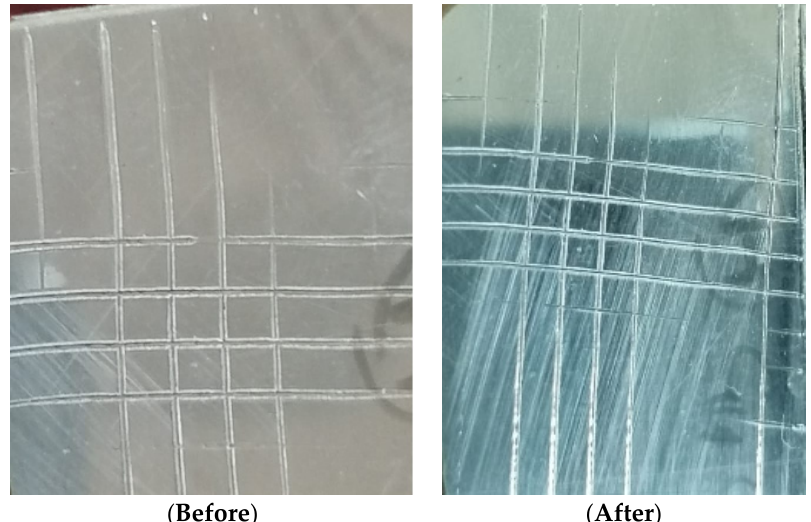
Figure 13. The cross-hatch method for measuring the adhesion of ncCuAg.